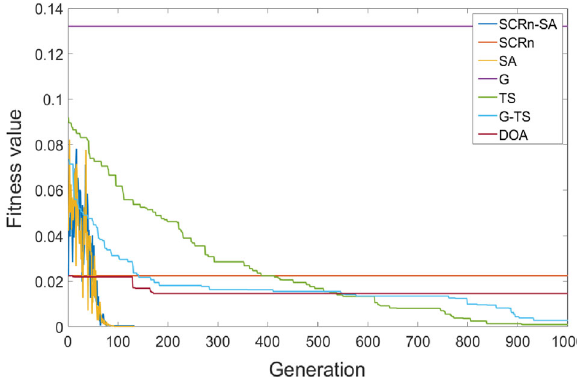
Fig. 16 Convergence curve for D